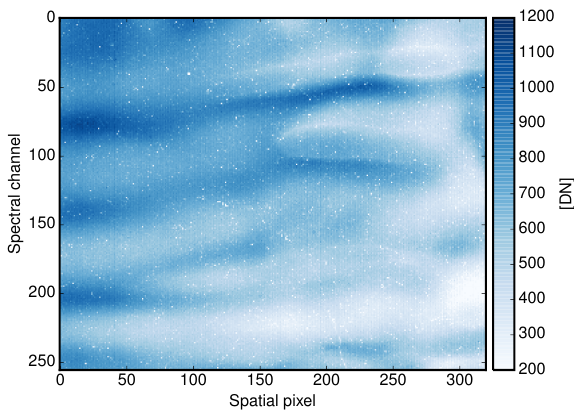
Figure 9. Extrapolated fixed pattern noise FPN SWIR in time at in- tegration time t int = 0s for the SWIR spectrometer. The measure- ments were done with closed shutter at multiple integration times and reduced to t int = 0s by linear regression. Table 3. Nonlinearity γ and integration time offset t ofs determined by fitting measurements to the model described in Eq. (8).